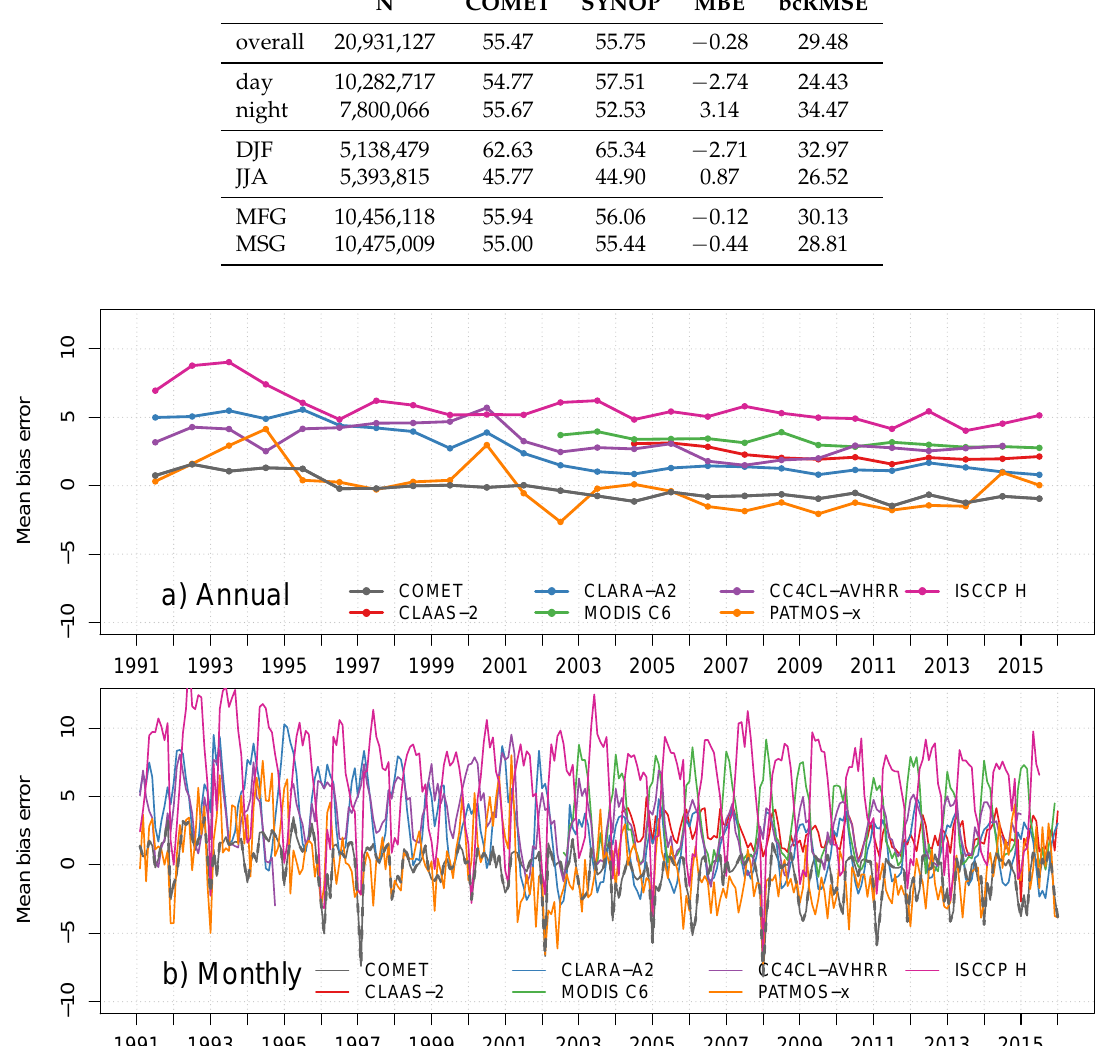
Figure 7. Mean Bias Error (MBE) of COMET CFC (grey) and inter-compared satellite-based CDRs compared with SYNOP at 237 sites. ( a ) displays annual mean MBE. ( b ) displays monthly MBE. Inter-compared datasets: Satellite Application Facility on Climate Monitoring (CM SAF) CLAAS-2 (red), CM SAF CLARA-A2 (blue), MODIS Collection 6 (green), ESA Cloud CCI CC4CL-AVHRR (violet), PATMOS-x (orange), and International Satellite Cloud Climatology Project (ISCCP) H